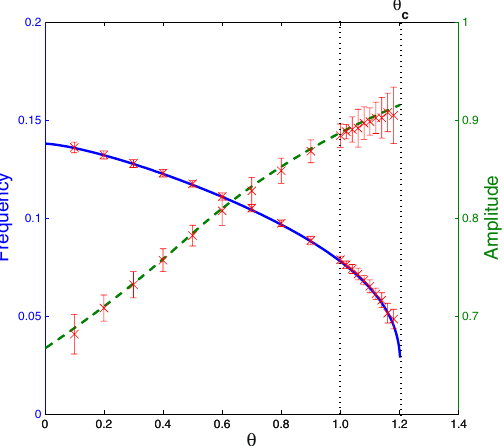
Figure 4. Frequency (solid blue) and amplitude (dashed green) of the limit cycle. Crosses (red) show the estimated means, with the bars giving the estimated standard deviations. The region between the dashed vertical lines indicates the intermittent